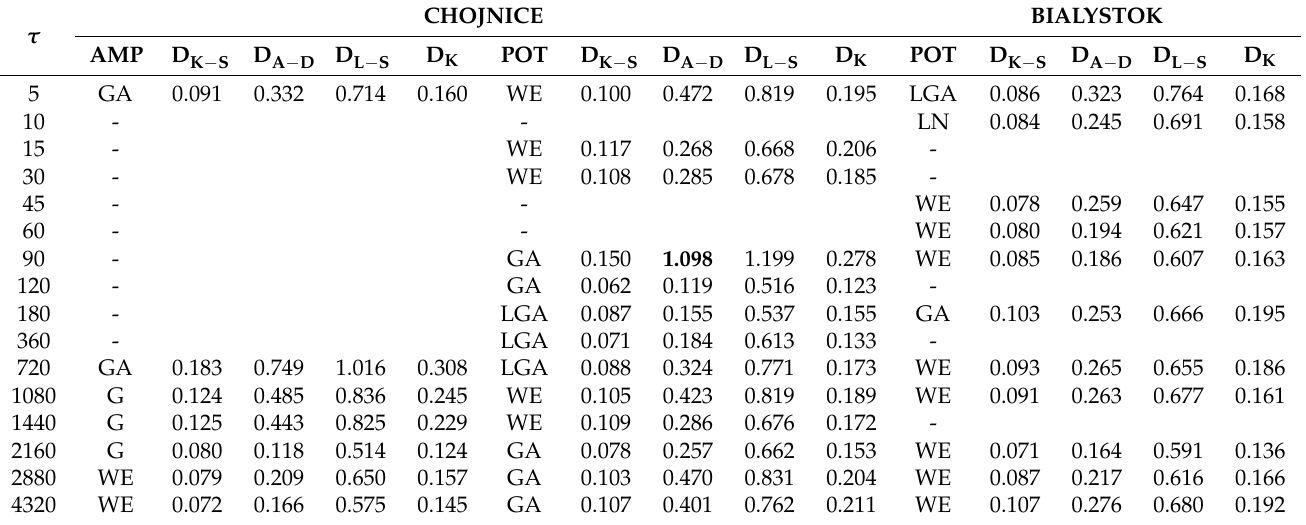
Table 8. Results of tests of fit of the theoretical probability distributions for P AMP τ and P POT τ ,